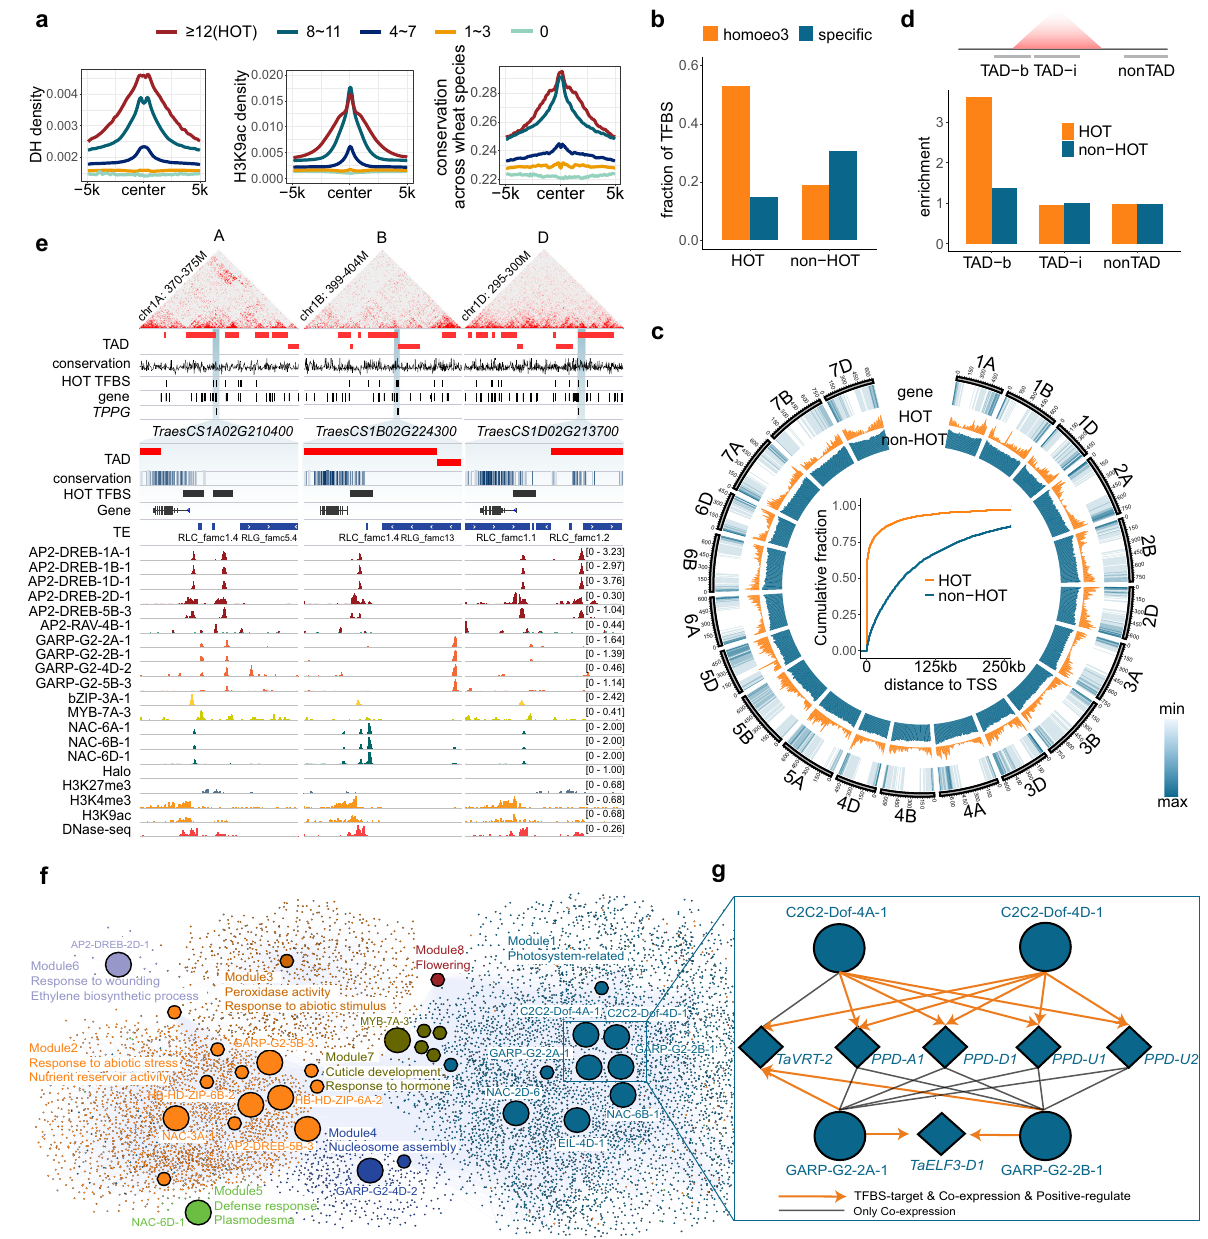
Fig. 2 | Chromosomal features of the regulatory circuit. a TFBSs were grouped according to the number of bound TFs. For each group, the average chromatin openness characterized by the DNase I hypersensitive site (DHS), the regulatory element activity characterized by the H3K9ac read density, and the sequence conservation across four wheat species with different ploidy levels are presented (see Methods).The average signaldensitiesand conservation scores are indicated at a 100-bp resolution within a 10-kb window centered on the merged TFBS cen- ters. Merged TFBSs with more than 12 binding sites were de fi ned as high- occupancy target (HOT) regions. b Fractions of HOT and non-HOT regions over- lapping subgenome-homoeologous regions and subgenome-speci fi c regions, which were de fi ned on the basis of the reciprocal alignment across subgenomes (see Methods). c Outer: Circos plot presenting the genomic distribution of gene density as well as HOT and non-HOT regions. Inner: cumulative fractions of the distance between a gene transcription start site and HOT regions or non-HOT regions. d Enrichment of HOT and non-HOT regions in the topologically